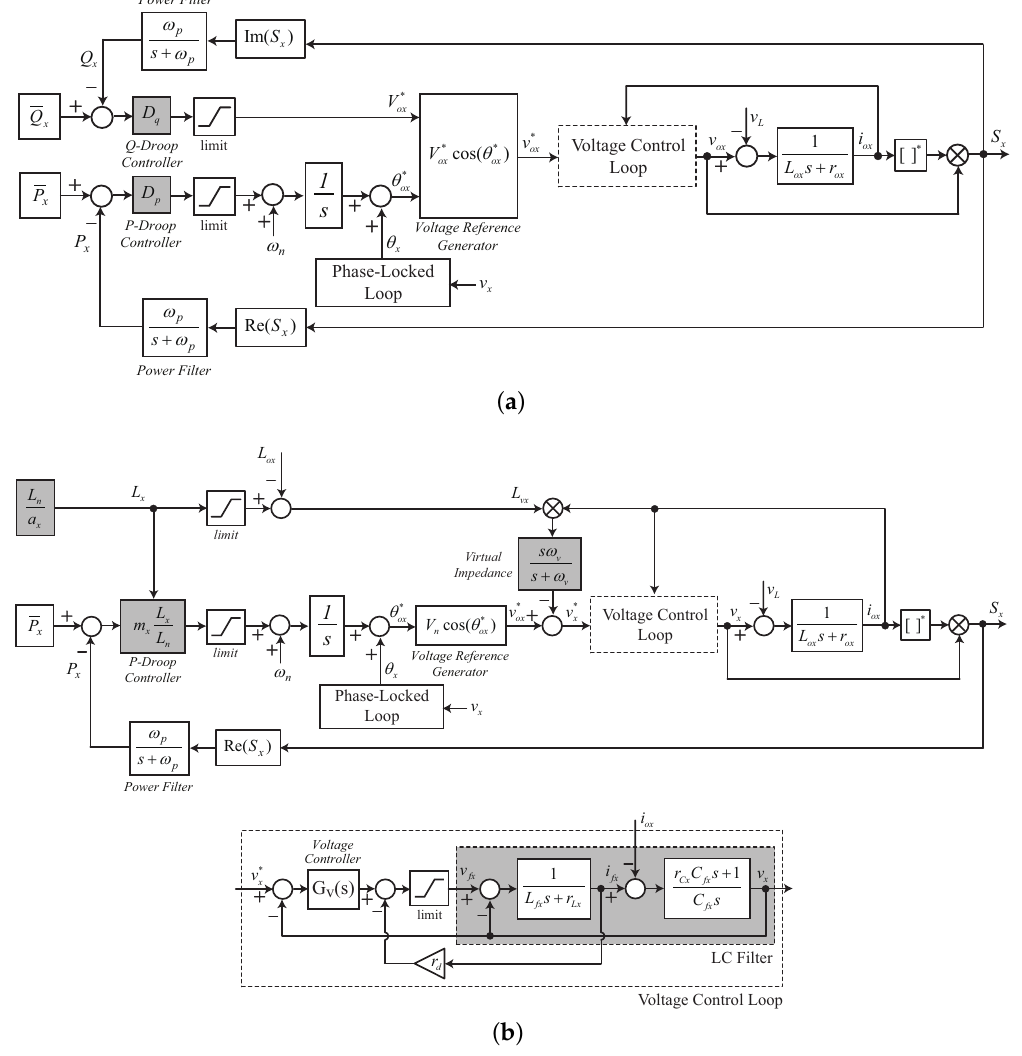
Figure 6. Overall control block diagram: ( a ) conventional droop method; ( b ) proposed active impedance control.